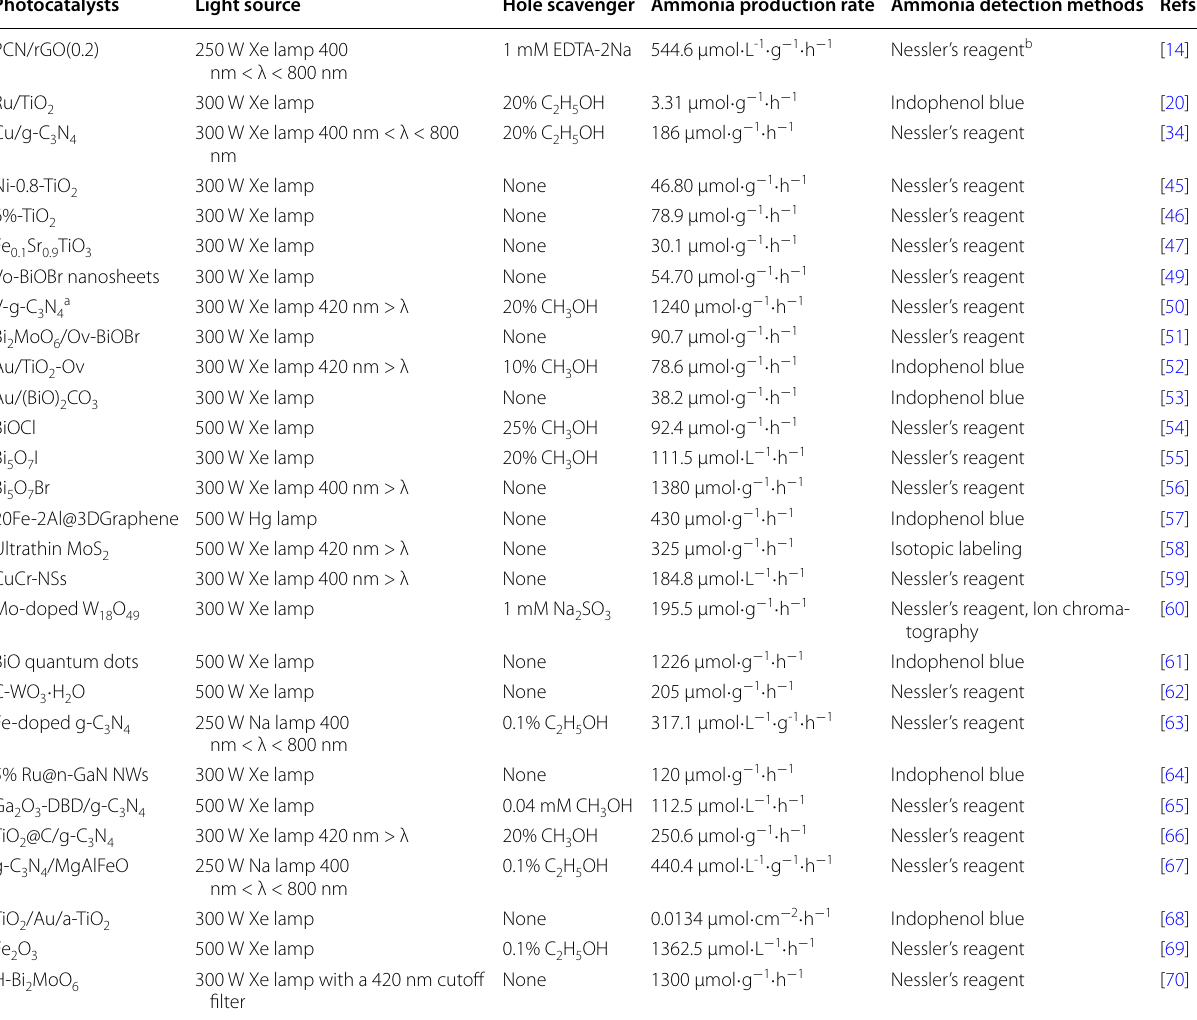
a Where V denoted nitrogen vacancies b Nessler’s reagent, K 2 HgI 4 , is one of photometric indicators for NH 3 detection and quantification [71]